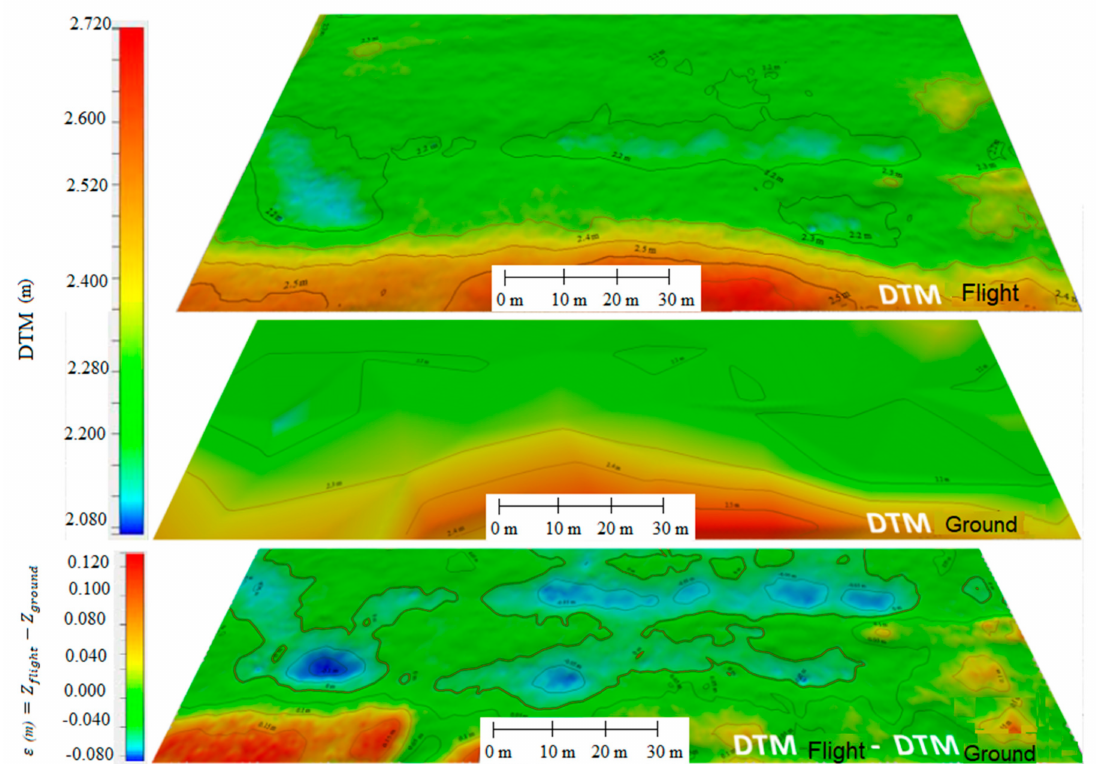
Figure 6. Map of the vertical error in every grid( ε ). Example of the difference between the altitudes of the flight digital terrain models (DTM) and the topographic DTM (GPS on the